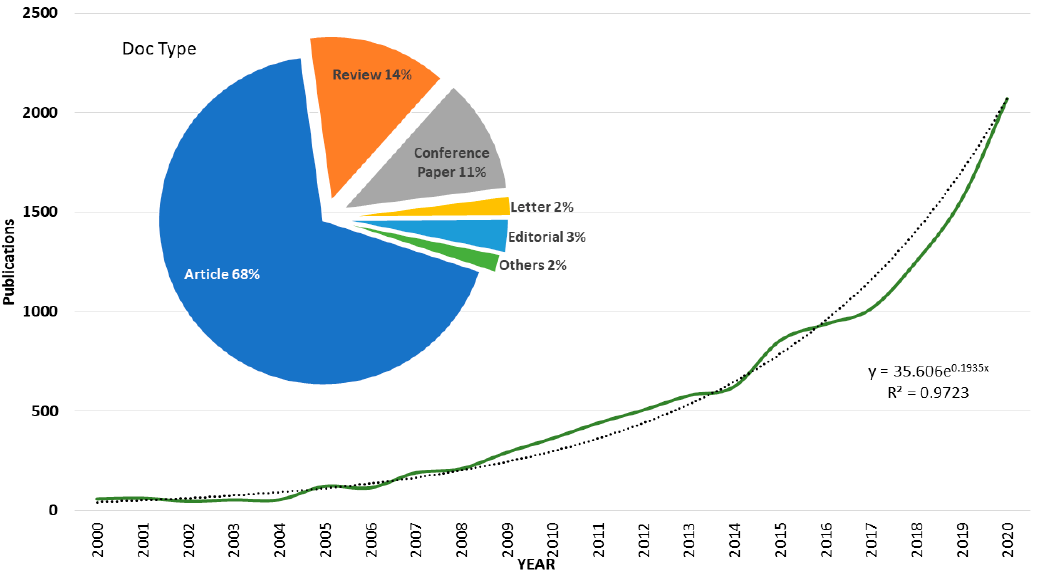
Figure 3. Bibliometric publications trend (Source WoS).